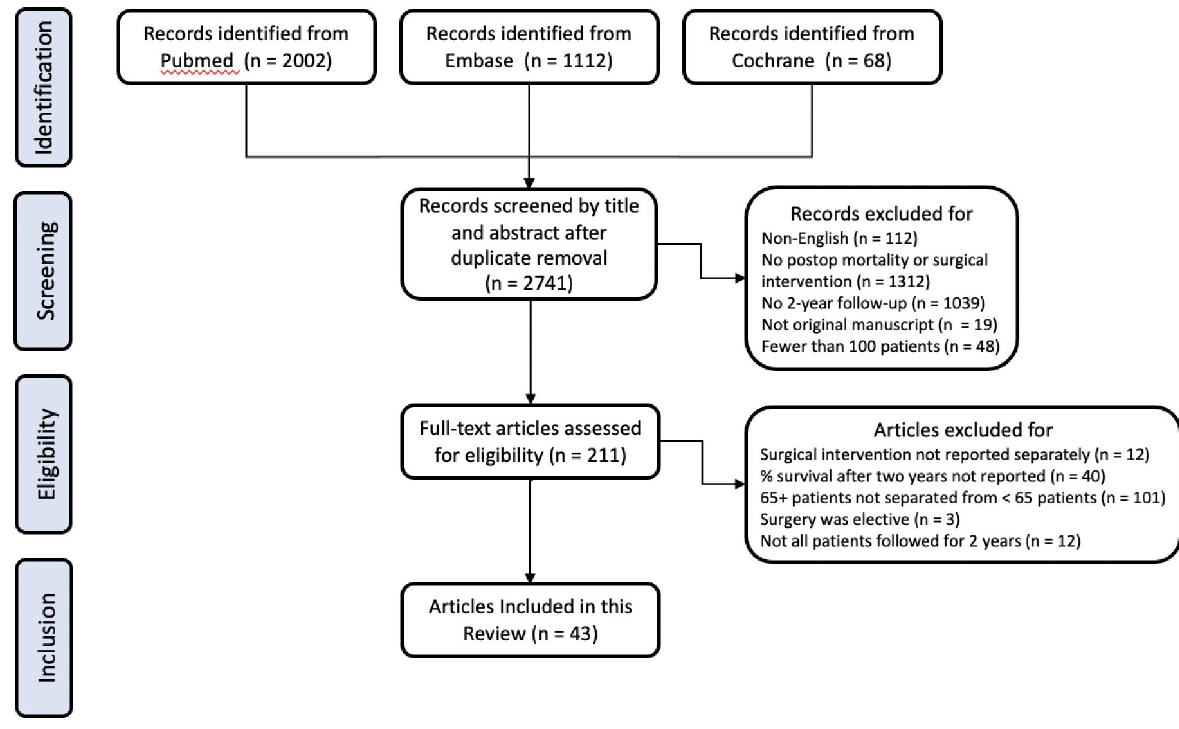
Fig 1. Flowchart of manuscript